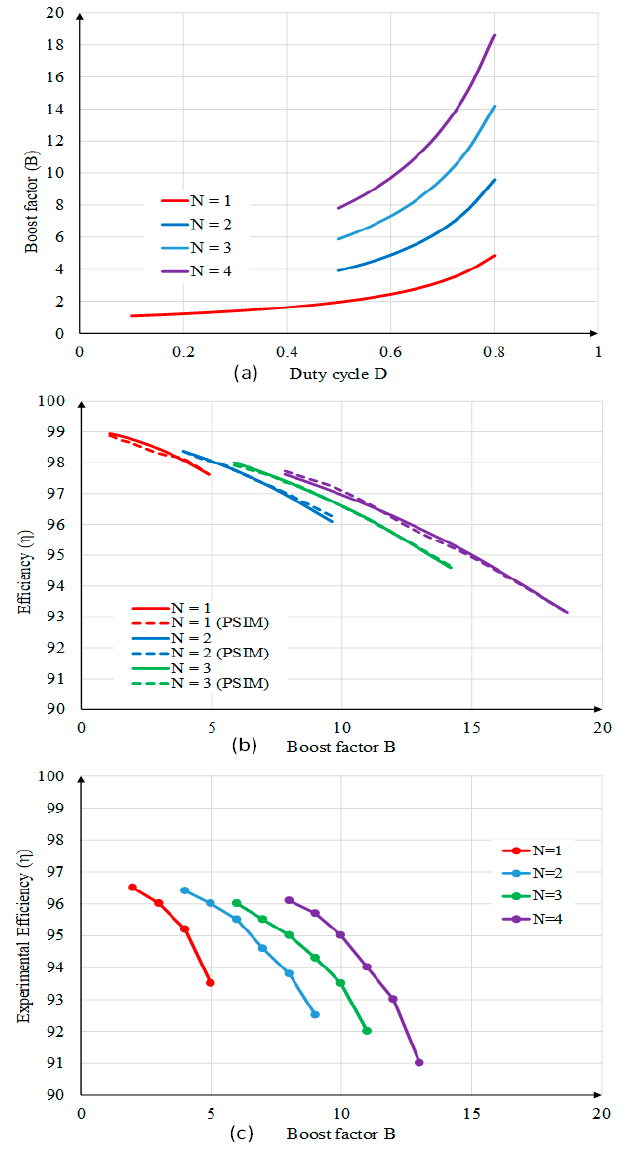
Figure 8. Boost ratio B ( a ), Efficiency η in calculated - simulation ( b ), and experiment ( c ) at Po = 500 W.